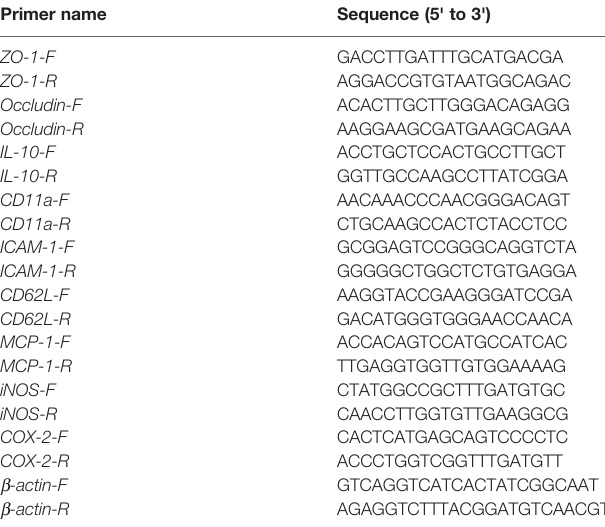
TABLE 1 | Primers for quantitative real-time (qRT)-PCR.